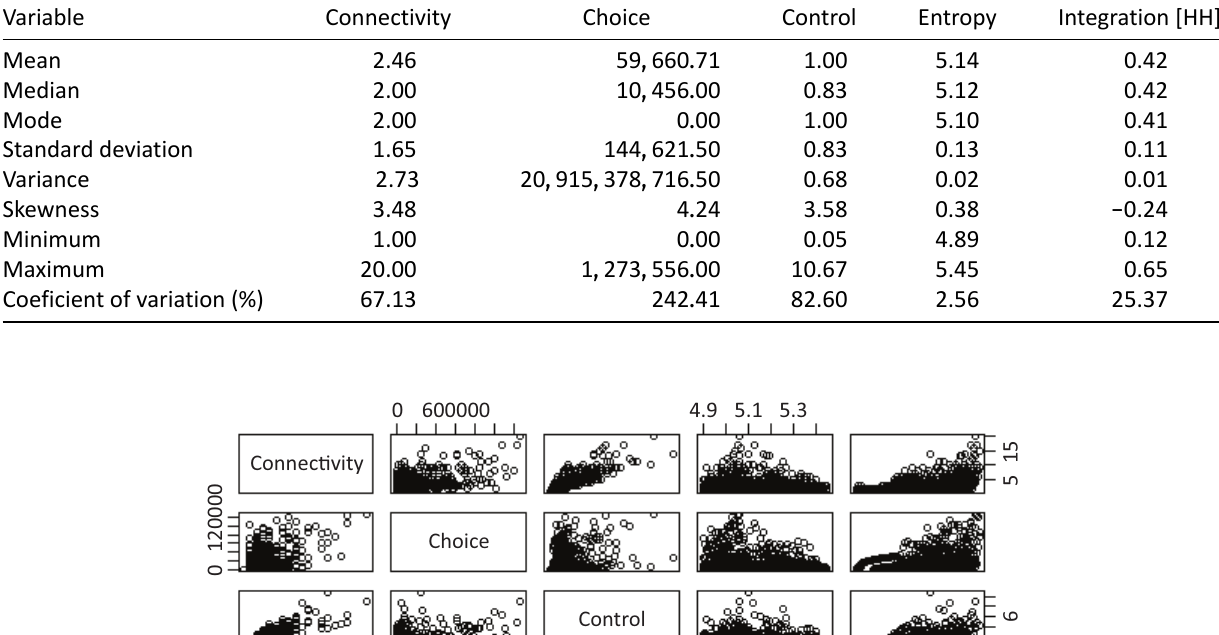
Table 1. Descriptive statistic of connectivity, choice, control, entropy, and integration global HH. Variable